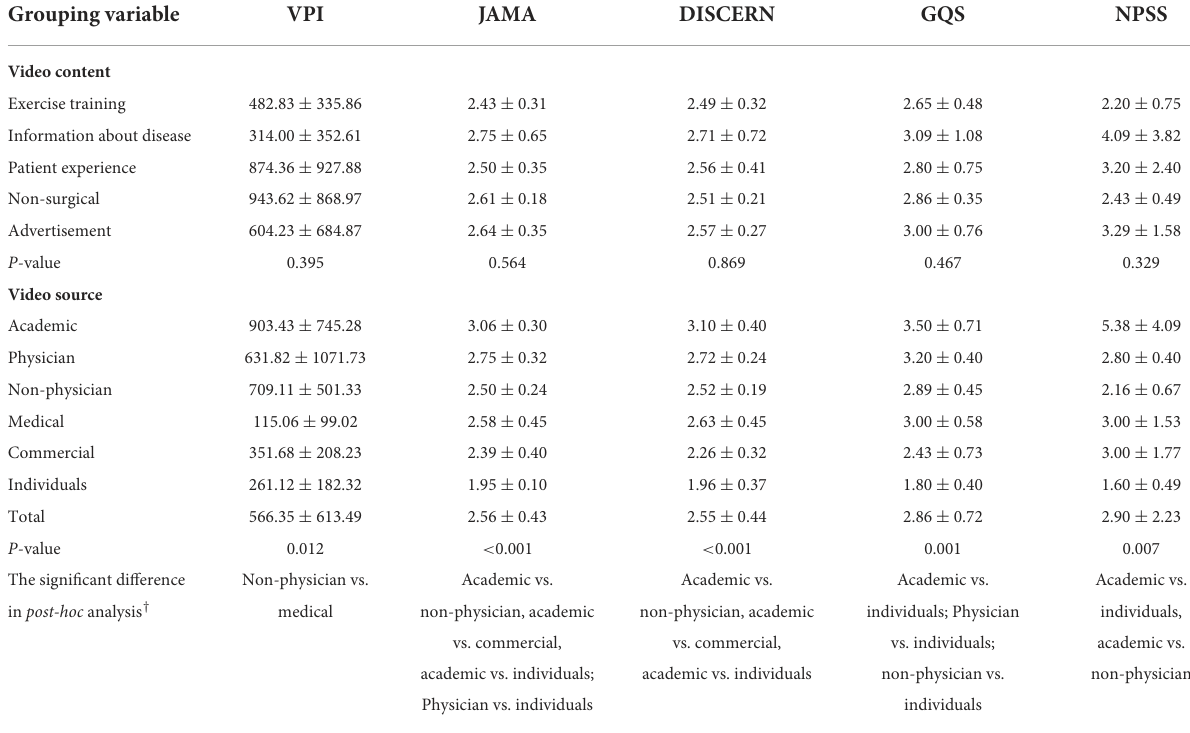
TABLE 5 Mean quality and reliability scores per video source and video content variable.